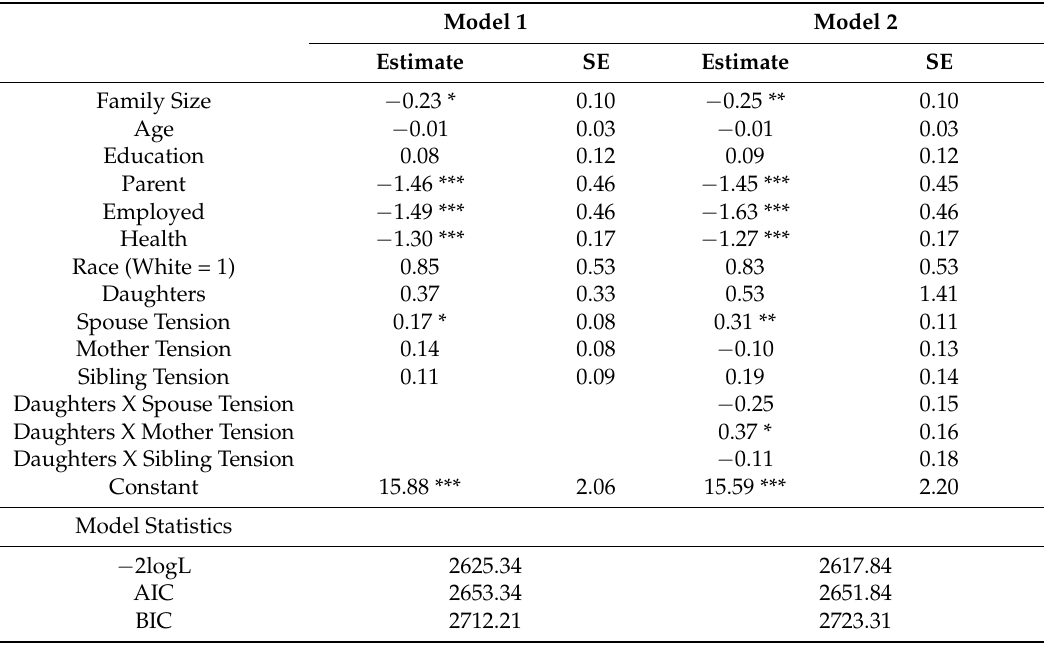
Table 4. Mixed Model Results Predicting Depressive Symptoms with Combined Tension Measures and Gender Interactions (N = 495).